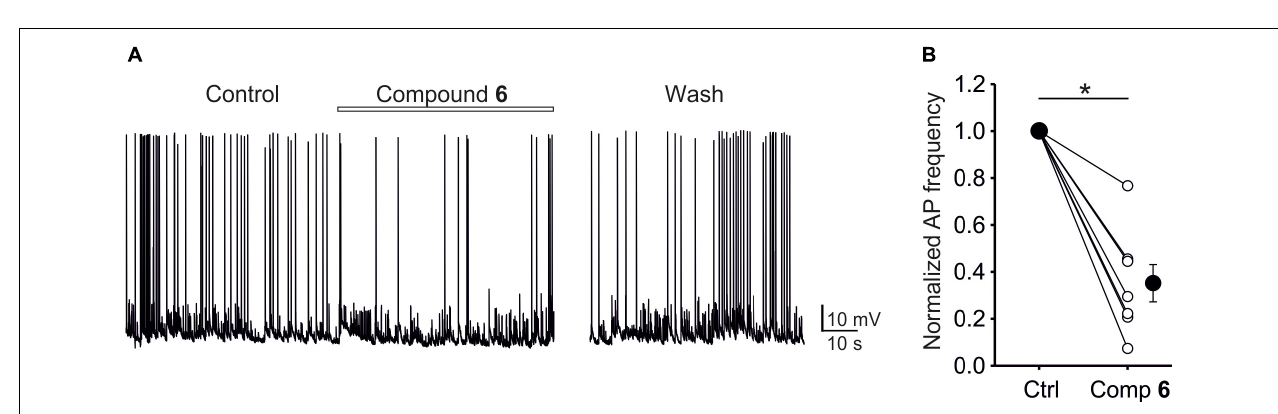
FIGURE 9 | The effect of compound 6 on native NMDARs, AMPARs, and GABARs. (A) Example of traces obtained from cultured hippocampal neurons. Compound 6 (10 or 30 µ M) was co-applied with NMDA (100 µ M), AMPA (100 µ M), and GABA (5 µ M) (duration of agonist and steroid application is indicated by filled and open bars, respectively). (B) Concentration–response curves for the compound 6 effect at NMDARs and GABARs. Data points are averaged values of normalized responses from six cultured hippocampal neurons. Error bars represent SD. The relative agonist induced responses ( I ) recorded in the presence of compound 6 (1–30 µ M) and determined in individual cells were fit to the following logistic equation: I = 1/(1 + ([ steroid ]/IC 50 ) h ), where IC 50 is the concentration of steroid that produces a 50% inhibition of agonist-evoked current, [ steroid ] is the steroid concentration, and h is the apparent Hill coefficient. A low degree of inhibition induced by compound 6 in case of native AMPARs precluded detailed dose-response analysis.